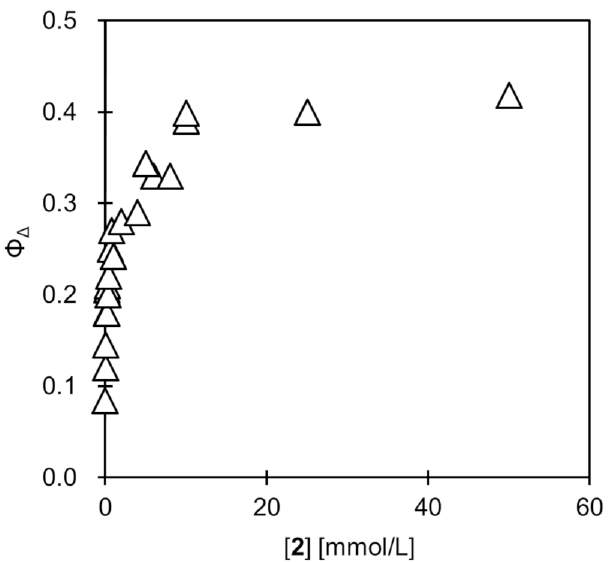
Figure 3. Change in singlet oxygen quantum yield ( Φ ∆ ) of 1 @AuNP after ligand exchange reaction with 1-dodecanethiol ( 2 ) in toluene. Conditions: [ 1 @AuNP] = 0.20 µ mol/L, [ 2 ] = 0–50 mmol/L, room temperature, 10 h. Saturated with oxygen at p O 2 = ca. 0.21